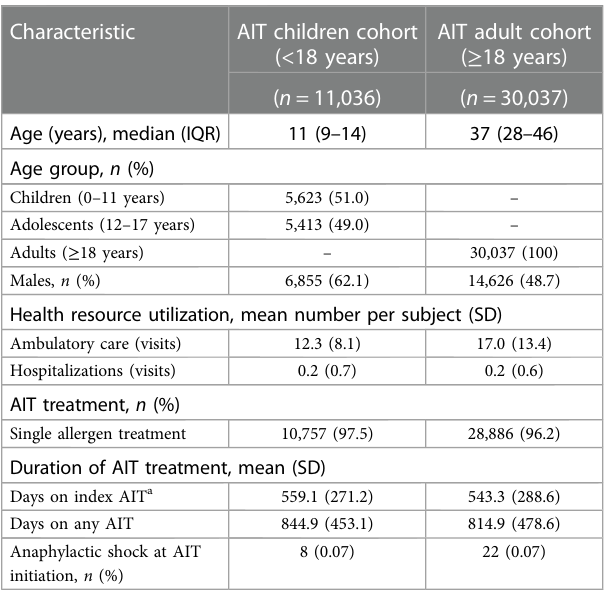
TABLE 1 Key characteristics of children and adults in the AIT